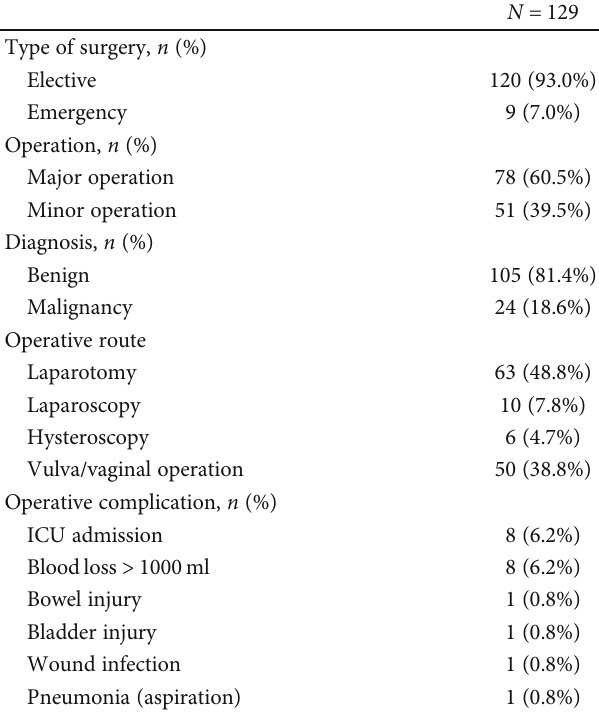
Table 2: COVID-19 screening results.